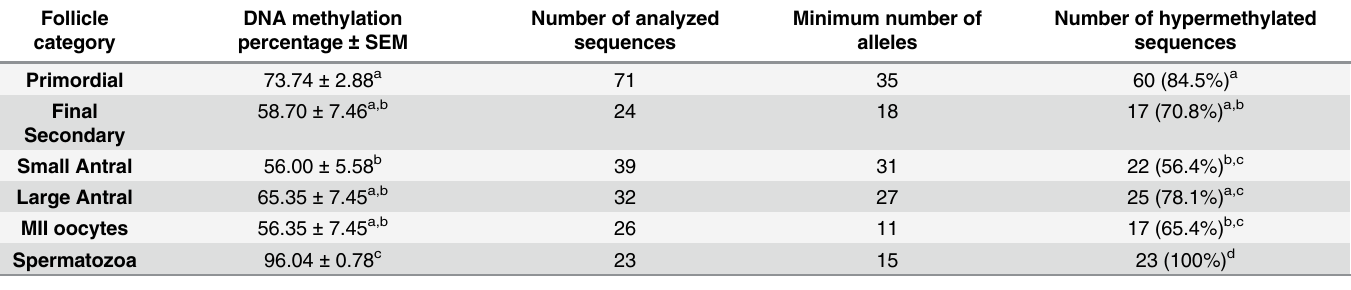
Table 3. The methylation percentage, number of analyzed sequences, minimum number of alleles and number of hypermethylated sequences (greater than 50% of methylated CpG sites) for each oocyte group and spermatozoa for the IGF2 gene.